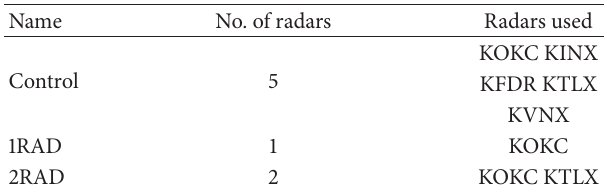
Table 1: List of analysis and forecast experiments showing the number of radars